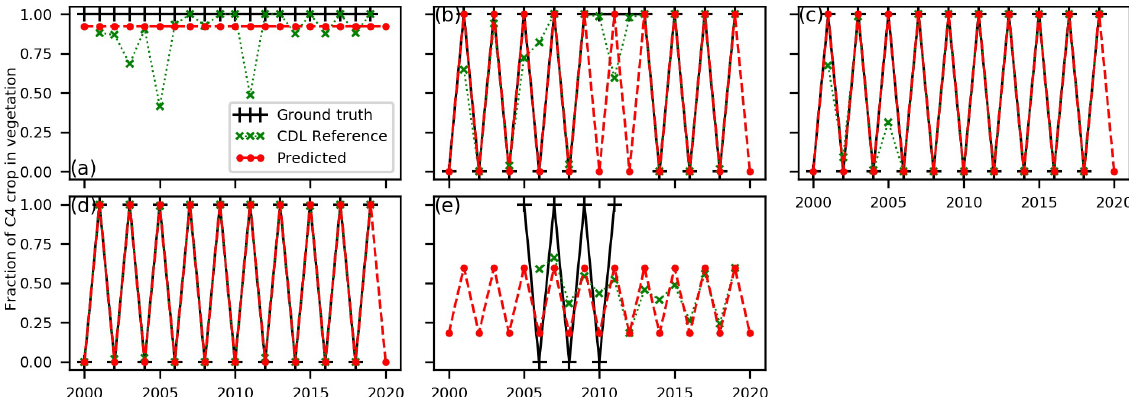
Figure 9. Comparison of fraction of C4 crop in vegetation between the field-collected ground truth, 250m resolution CDL data and 250m resolution SLOPE predictions at six AmeriFlux sites (Table S3) in the US Corn Belt from 2000 to 2020. (a) US-Ne1 (uncertainty: 0.17; Mead – irrigated continuous maize site). (b) US-Ne2 (uncertainty: 0.40; Mead – irrigated maize–soybean rotation site). (c) US-Ne3 (uncertainty: 0.18; Mead – rainfed maize–soybean rotation site). (d) US-Bo1 (uncertainty: 0; Bondville). (e) US-Ro1 (uncertainty: 0.16; Rosemount – G21). Uncertainty is the RMSE between the predicted and the CDL